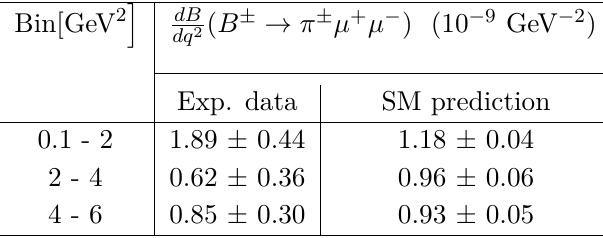
Table 7 . Comparison of the SM predictions for the CP averaged differential branching fractions with the experimental measurements from LHCb